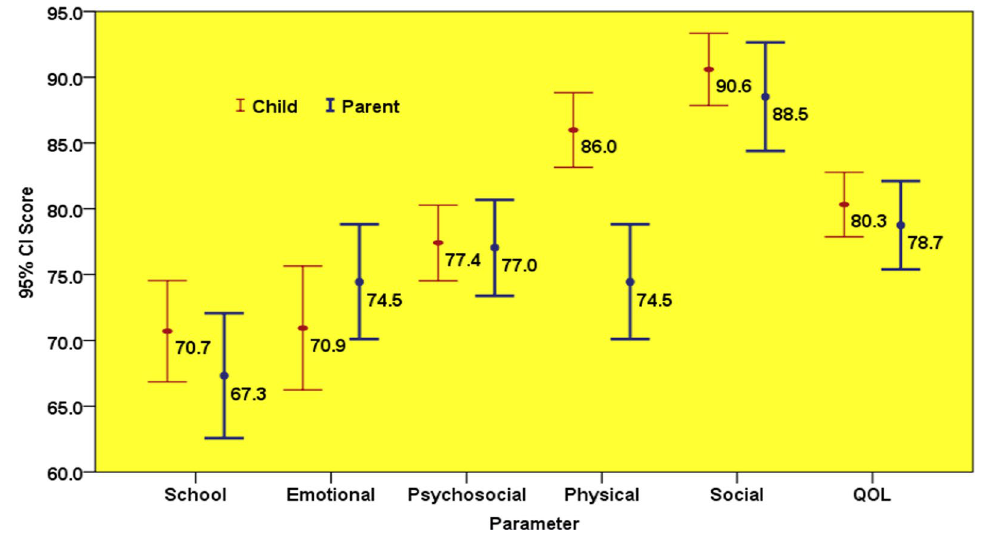
Fig. 3 Comparison of child and parent reported QoL in different domains